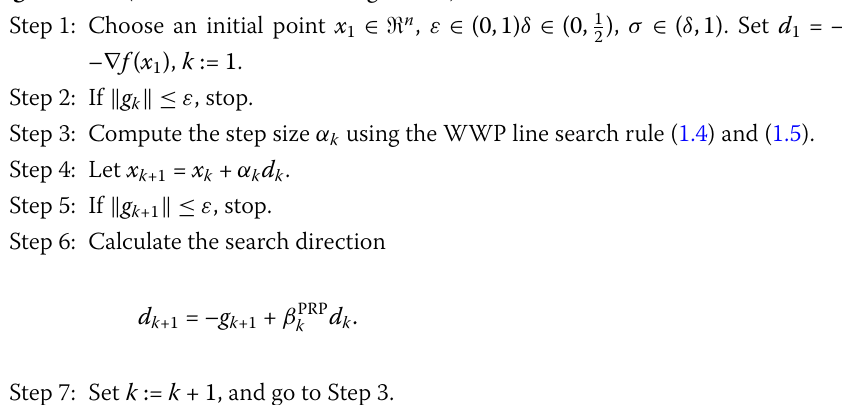
Algorithm 2 (The normal PRP CG